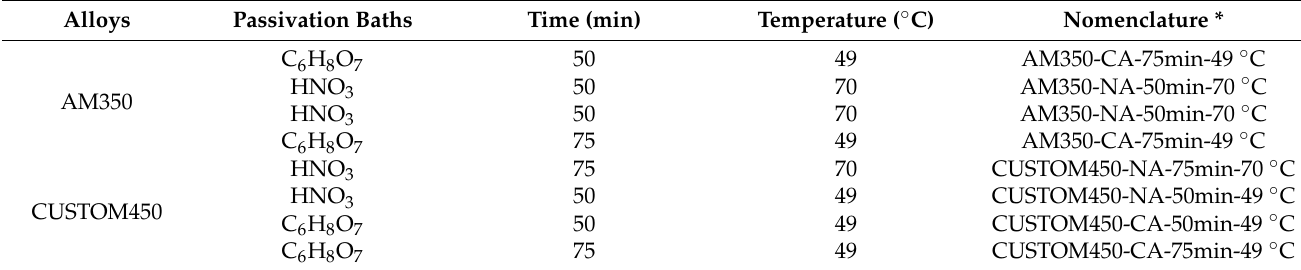
Table 2. Nomenclature and passivation process